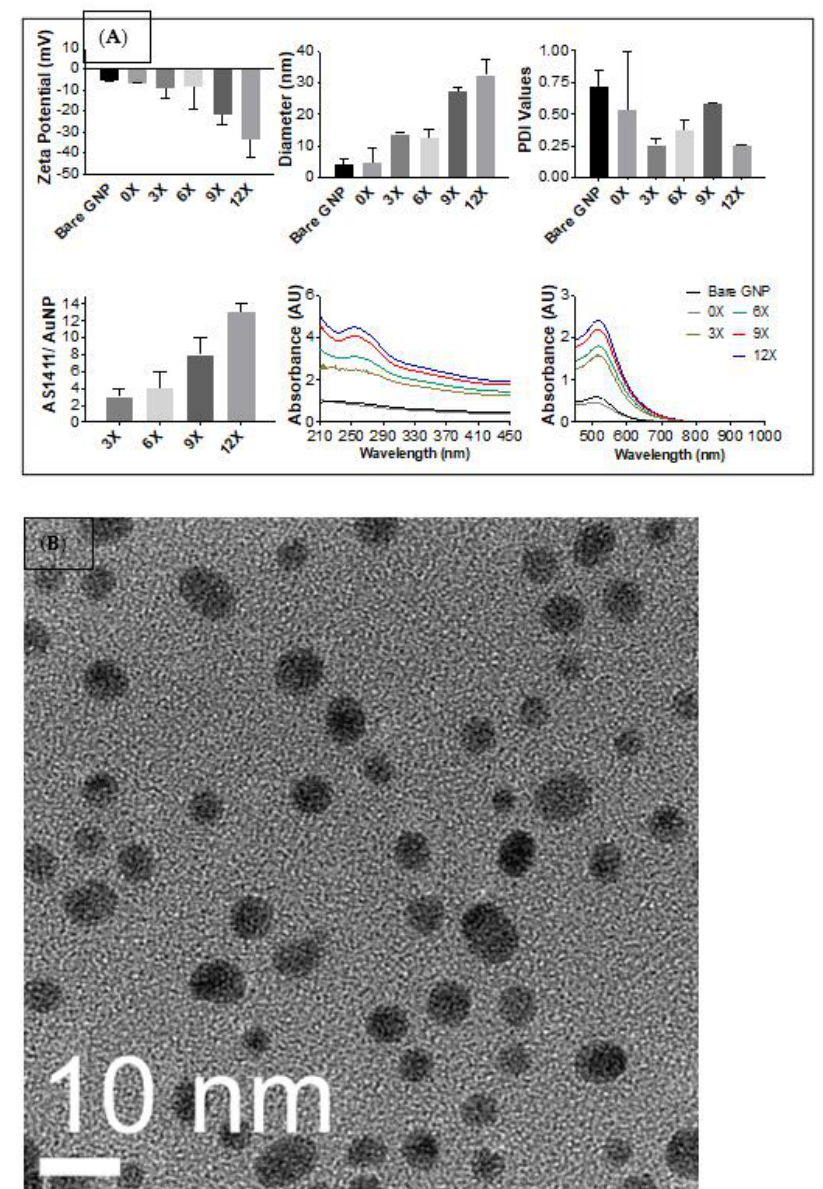
Figure 3. ( A ) Characteristics of various syntheses of PEG-AS1411 co-conjugated 4 nm GNPs. The top panel shows each synthesis’s zeta potential, diameter, and PDI values and compares them to citrate-capped bare GNPs. The bottom panel shows oligo loading within particle syntheses and resulting UV-VIS spectra for each. ( B ) TEM image of GNP-AS1411 (0X). Average particle size was measured to be 4.53 ± 0.78 nm.